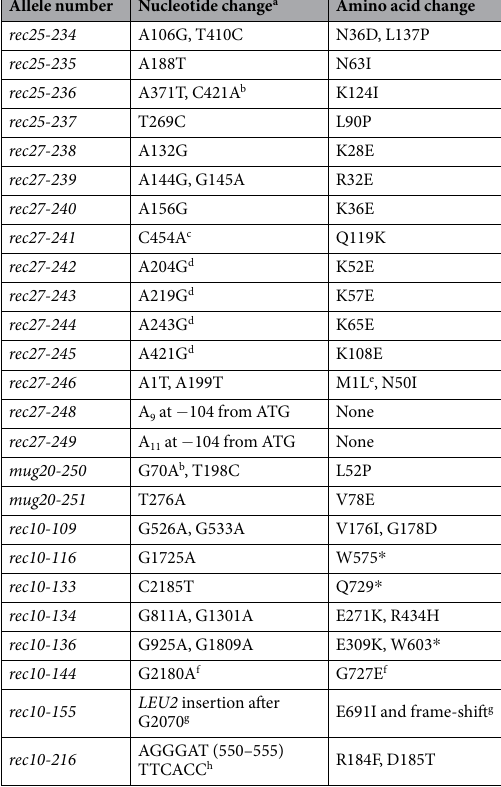
Table 1. Nucleotide and amino acid changes in LinE mutants. a Relative to ATG (A = bp 1 of the revised rec27 ATG; see Fig. 3B). b Nucleotide change does not change protein coding. c With additional mutation A 9 at − 104 from ATG. d Site-directed mutation. e The nucleotide change at the translational start, from ATG to TTG, is unlikely to allow translation to begin. f From 22 . g From 11 . h Isolated by random mutagenesis of two codons (R184 and D185). * Non-sense